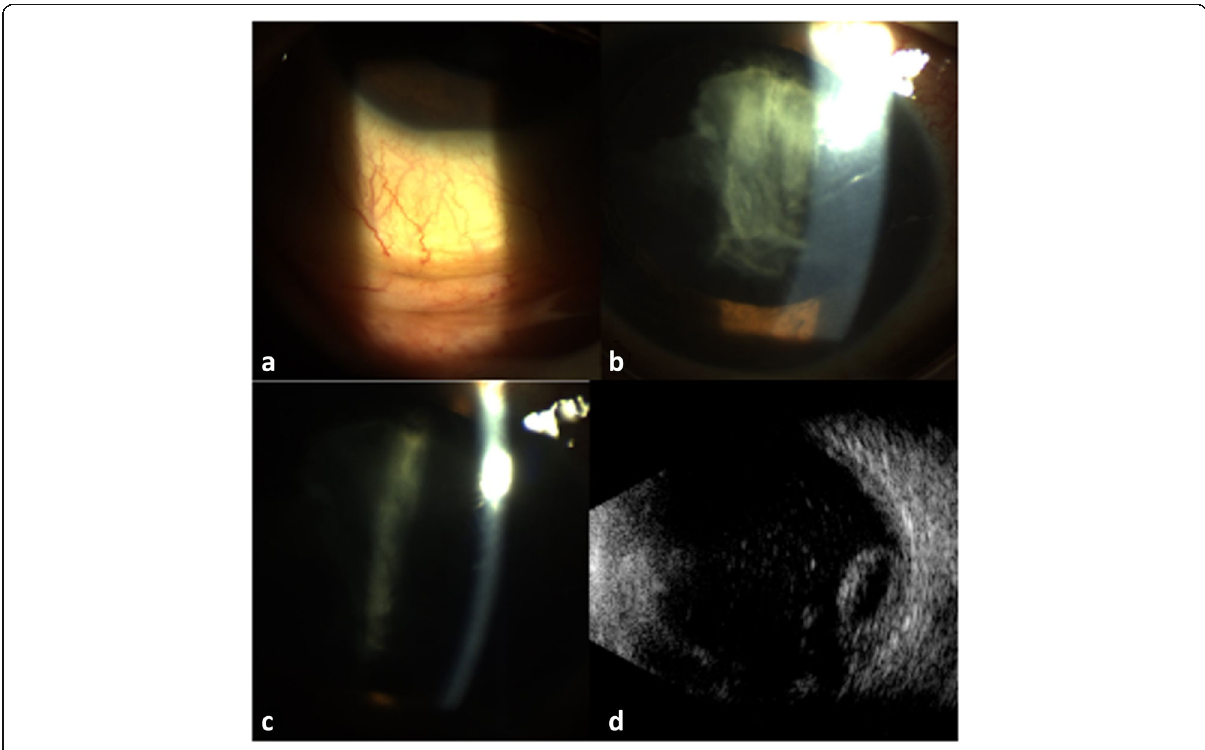
Fig. 1 (a) Slit-lamp photography seven days after pars plana vitrectomy showing a mild conjunctival hyperemia and hypopyon. (b,c) Three days after initiation of topical steroid therapy, the hypopyon has resolved. Note the lack of typical lens capsule convexity and the residual cortical material adherent to the anterior lens capsule. (d) B-scan ultrasonography shows a globular echogenic structure in the inferior posterior vitreous cavity resting on the retina consistent with a dislocated lens